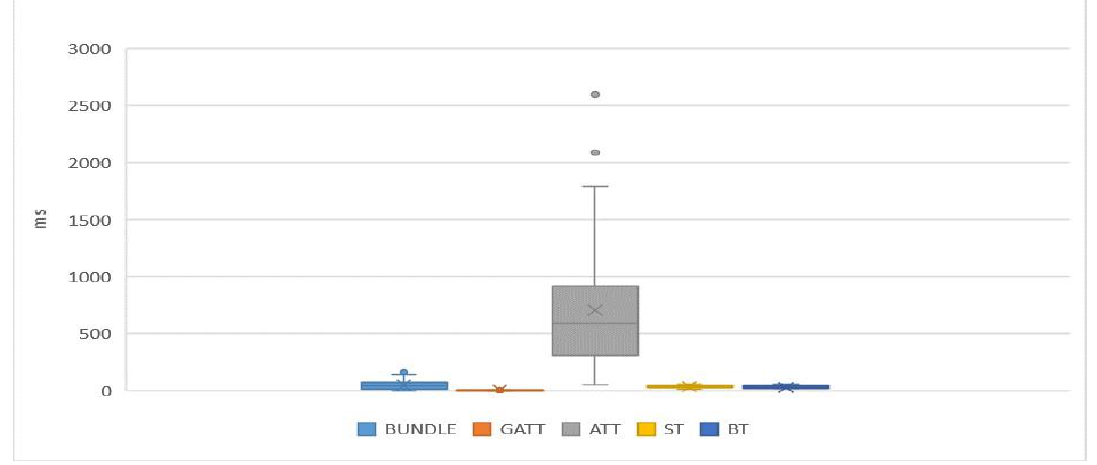
Figure 9. Cost of transaction publishing.